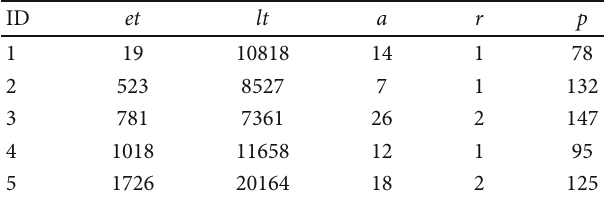
Table 1: Example of satellite data transmission task.